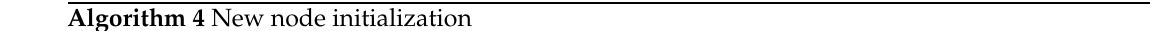
Algorithm 4 New node